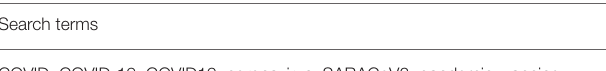
TABLE 1 | COVID-19 related terms used in Twitter